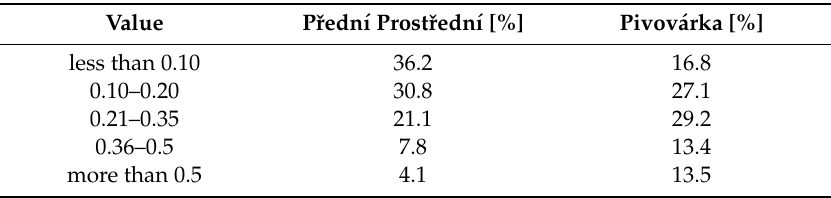
Figure 11. Detail of a ‘supernormal strip of fertile land’ in a form of a valley where relative yield reaches up to 180% of the mean yield for the whole plot. Table 1. Representation of the percentage of uncertainty values per